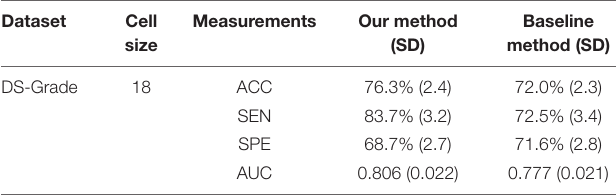
TABLE 2 | Comparison of the glioma grading performance evaluated by 10-fold cross-validation between the baseline concatenating HOG method and our proposed transformed HOG method.